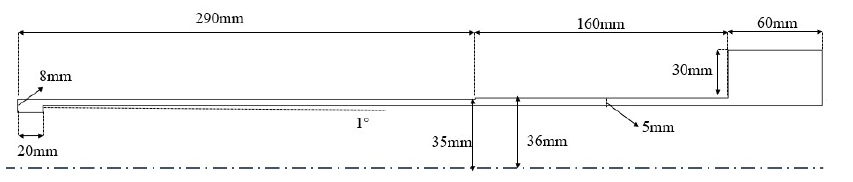
Figure 2. The schematic area of the numerical models.